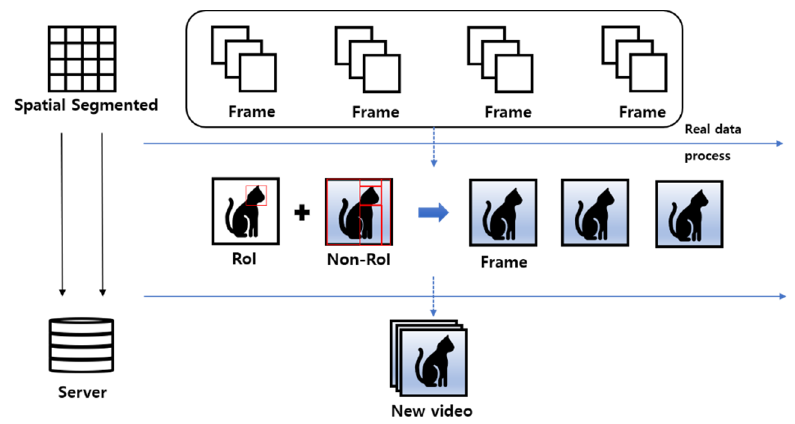
Figure 13. SST network model.